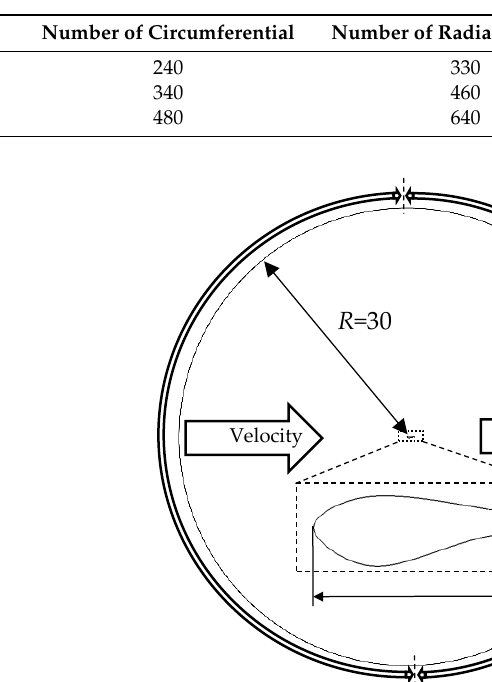
Figure 1. Computational mesh. Table 1. Mesh distribution.